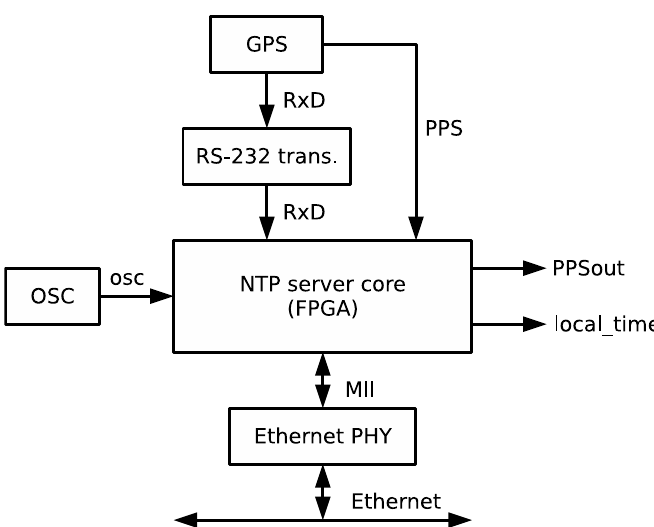
Figure 4. NTP server core and external elements.